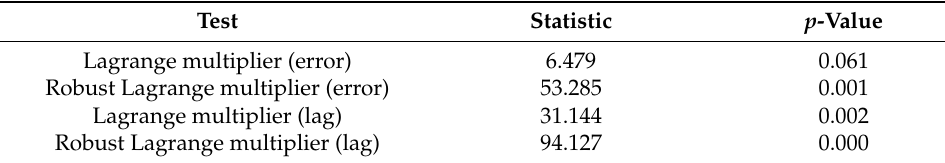
Table 4. LM test